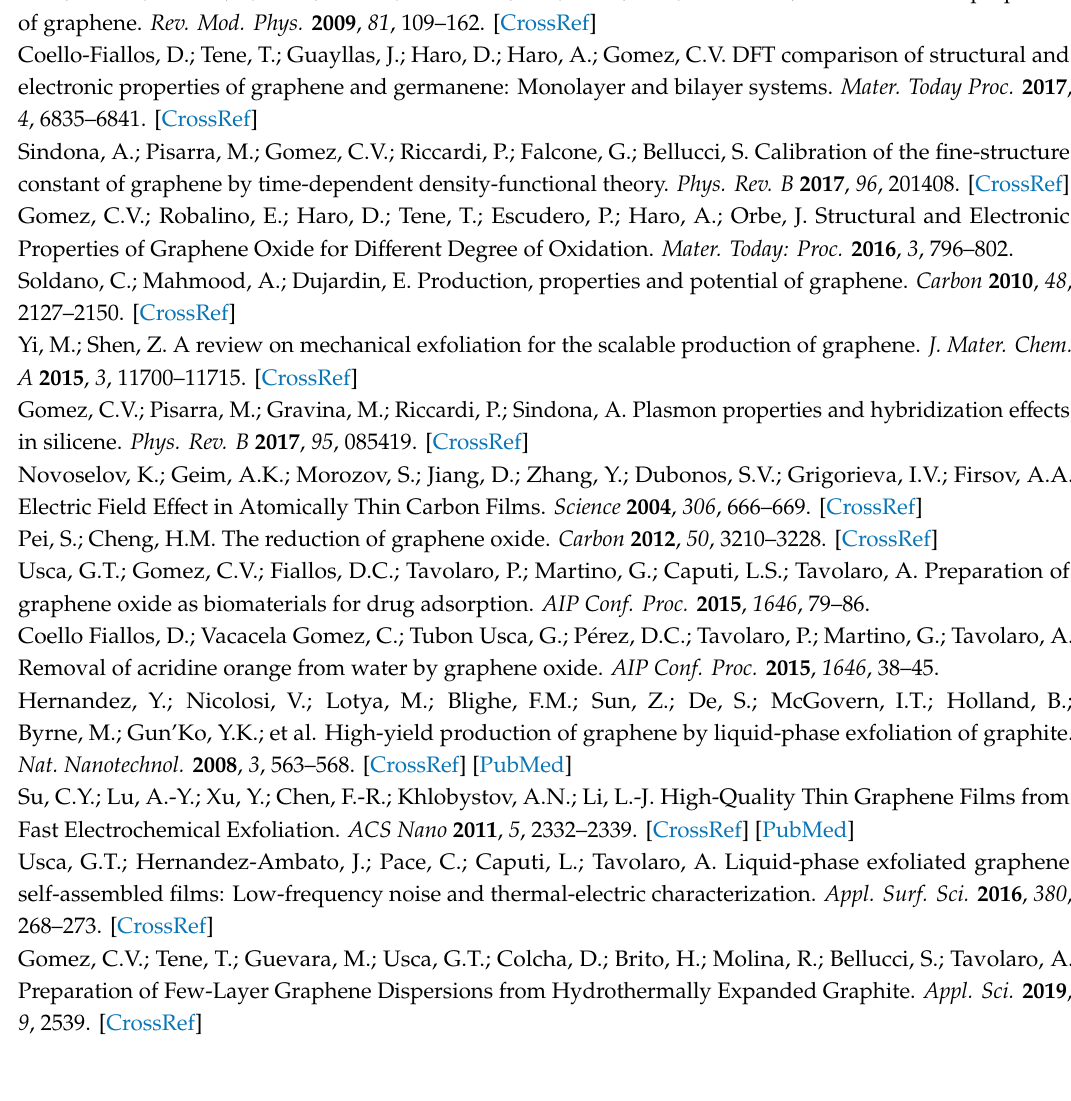
Figure S1: Raman spectrum of (a) zeolite 4A (Z4A) and (b) graphene dispersed in NMP + Z4A after centrifugation for 10 min at 1000 rpm. (Inset) Sampled